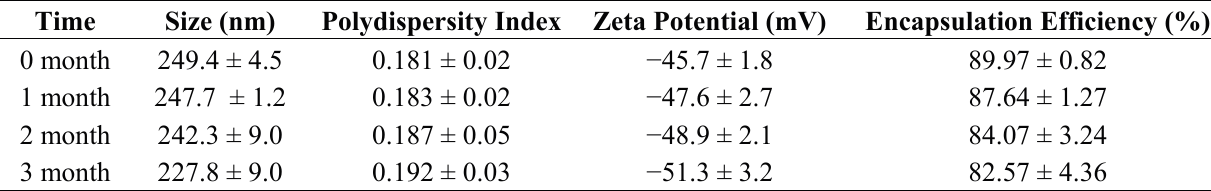
Table 2. The storage stability of PTX-loaded GA micelles at 4 °C. Data were presented as the Mean ± S.D. ( n =